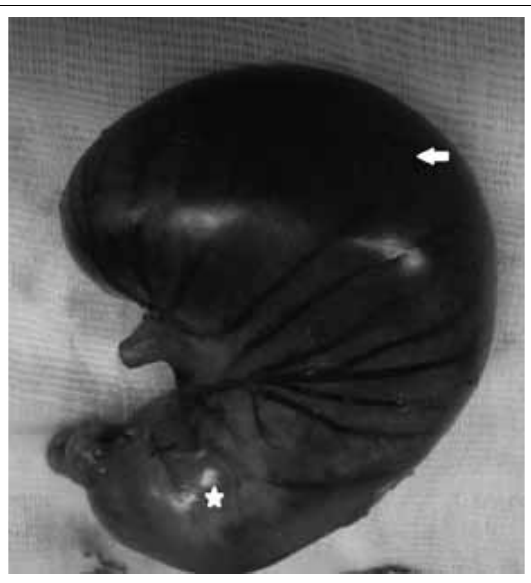
figurE 2 – Macroscopic aspect of the opened stomach of the same rabbit of Figure 1 after 6 hours of gastric ischemia: presence of diffuse hemorrhagic necrosis in the body and fundus regions (arrow), whereas the antral region (*) is preserved